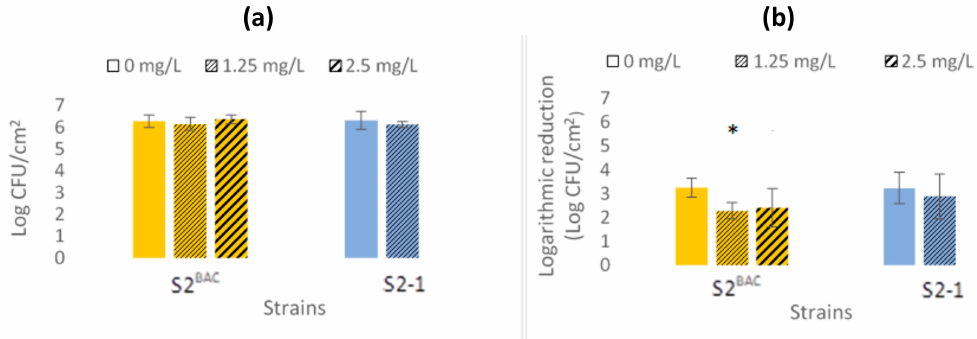
Figure1. Antibiofilmactivityofbenzalkoniumchloride(BAC).( a )Biofilmcellenumeration: comparison of the biofilms formed by cell enumeration on stainless steel coupons, after incubation for 48 h at 25 ◦ C, under di ff erent sub-inhibitory BAC concentrations. ( b ) Biofilm logarithmic reduction: comparison of the log reduction, after BAC exposure (1280 mg / L, 5 min), of the biofilms formed under di ff erent sub-inhibitory BAC concentrations. The presence of an asterisk in the bar indicates significant di ff erences from the other conditions ( p < 0.05). The values shown are averages of four replicates. Standard deviations are